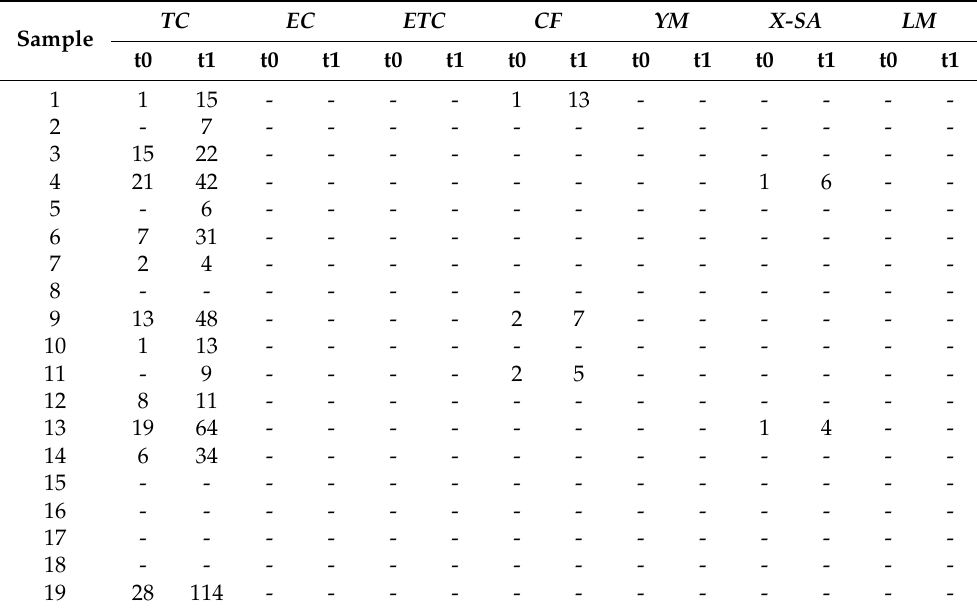
Table 3. Microbiological assessments before (t0) and after storage